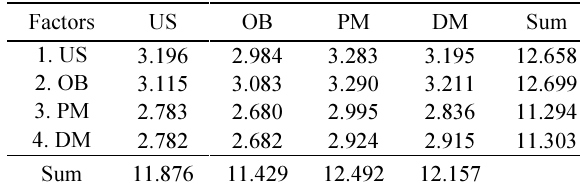
Table 9. Indirect influence matrix ID of factors